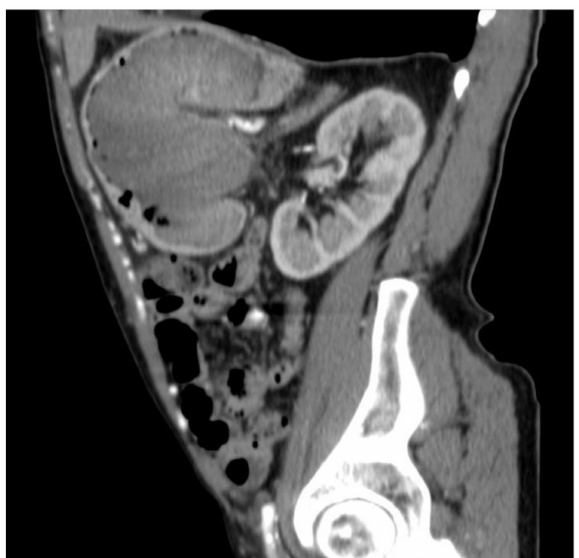
Figure 4. Gastric lesion in the arterial phase in the sagittal section.